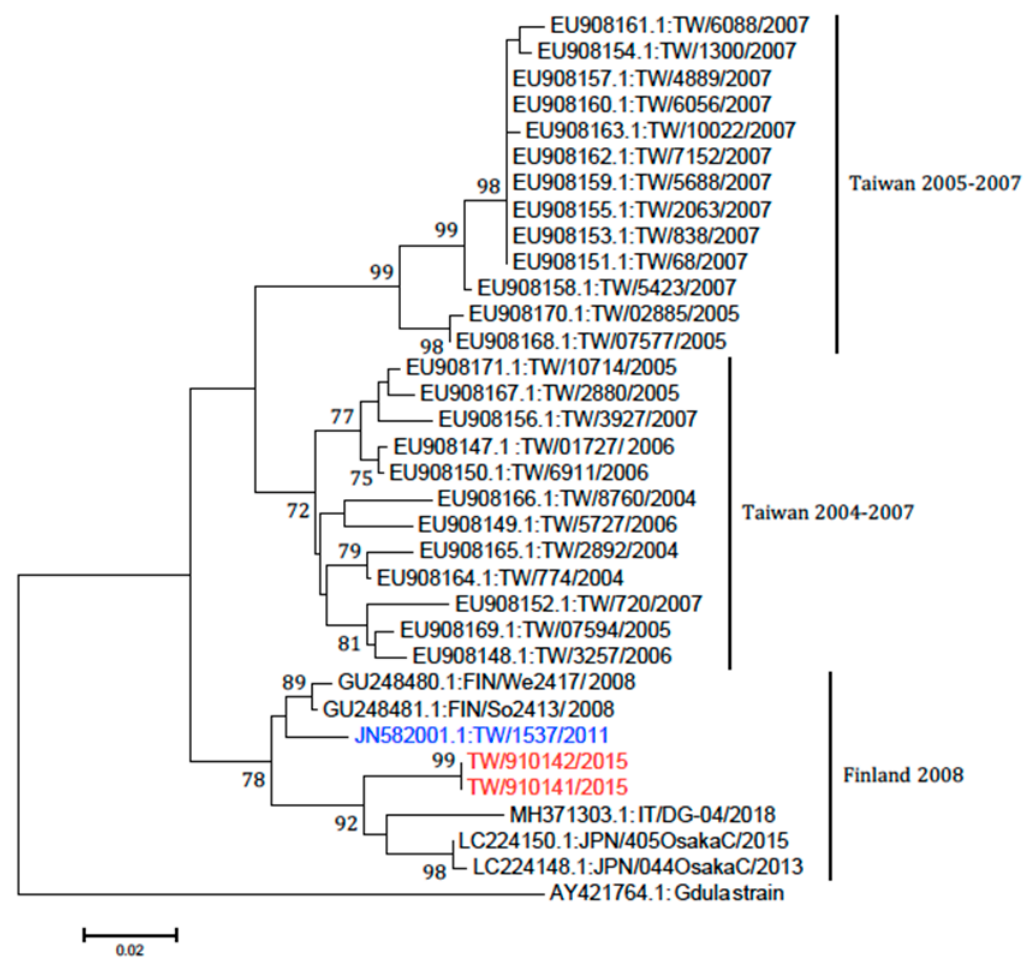
Figure 3. Phylogenetic analysis of Coxsackievirus A6 strains. The partial VP1 gene sequences (377 nucleotides) of our A6 strains (TW / 910141 and TW / 910142 in red) and the strains in Taiwan from 2004 to 2011 along with six sequences obtained from Genbank (two from Finland, two from Japan, one from Italy, and the prototype strain, Gdula) were used for the phylogenetic analysis. One strain (highlighted with blue) is identical to Finland strain we published in 2013.